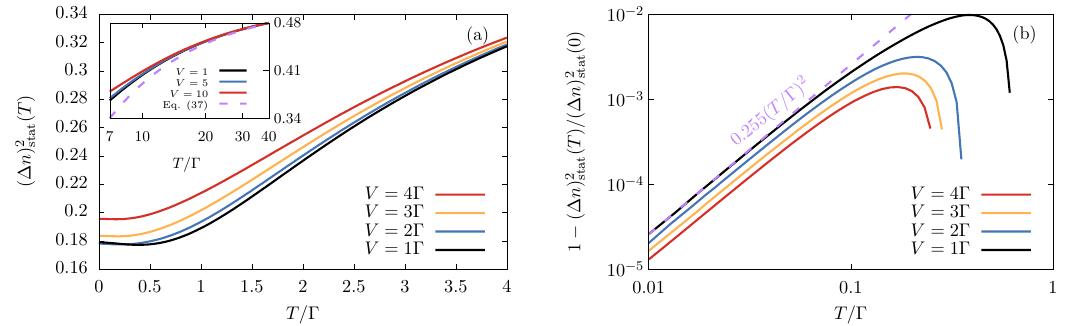
Figure 2: Stationary charge fluctuations ( ∆ n ) 2 U = 8 Γ , ε = − U / 2 and several bias voltages. (a) Low and intermediate temper- ature regime. Inset: High temperature regime. (b) Scaling of the fluctuation for T (cid:28) Γ